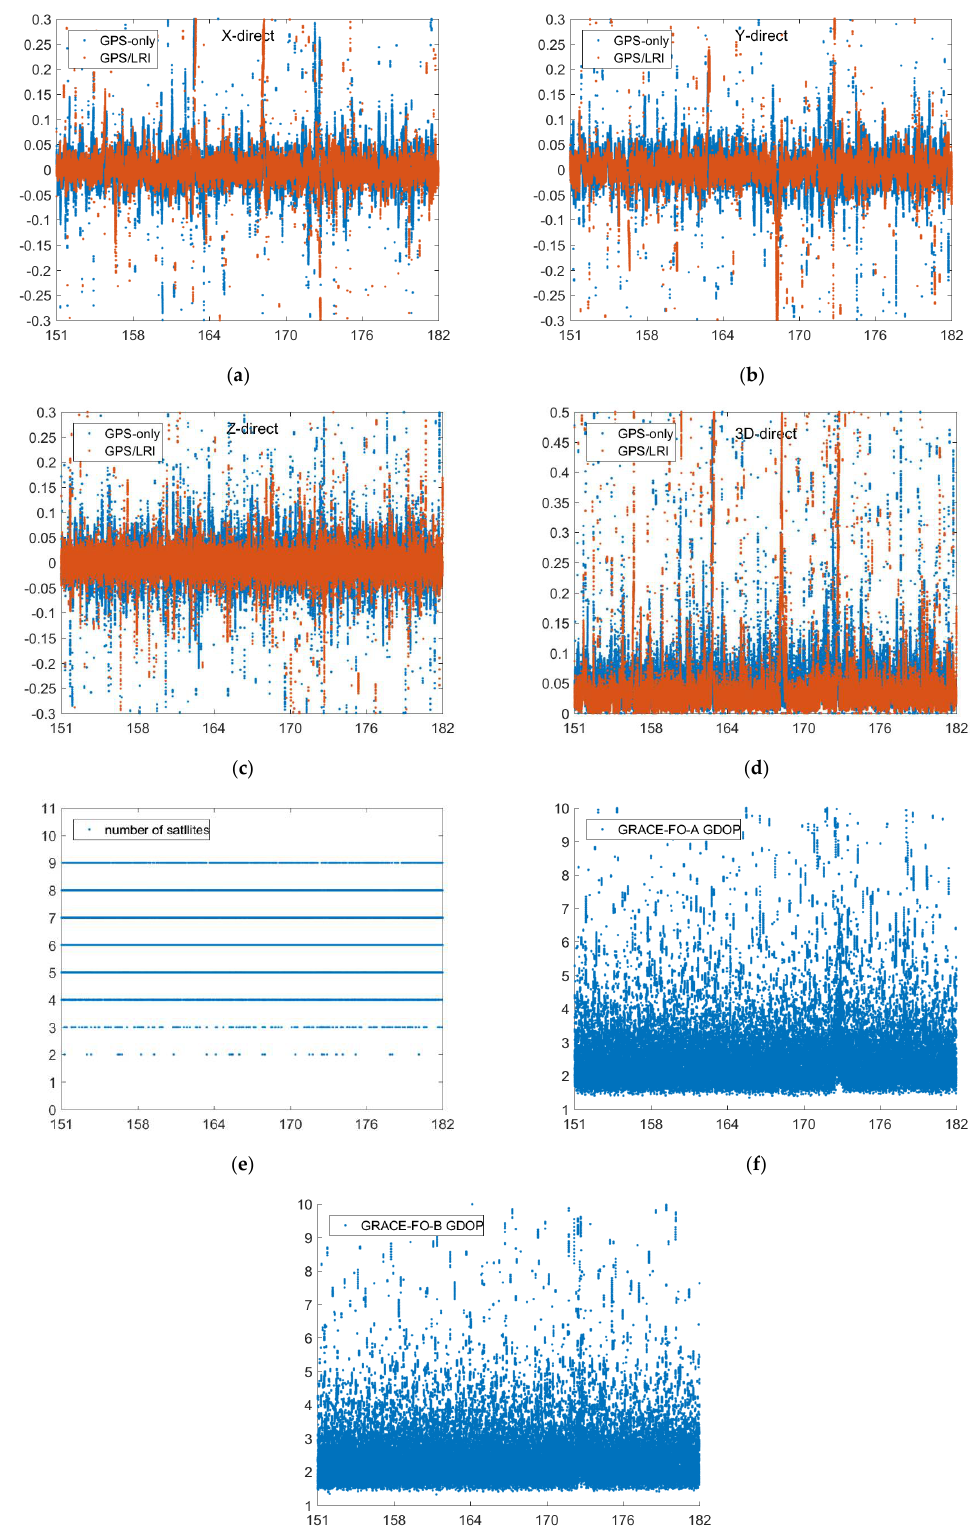
Figure 2. Reference orbit check for GRACE-FO in the X, Y, Z, 3D (X, Y, Z are components of the baseline vector, unit: m , ( a – d )) directions (days 121–151), number of satellites for each epoch( e ) and GDOP( f , g ).